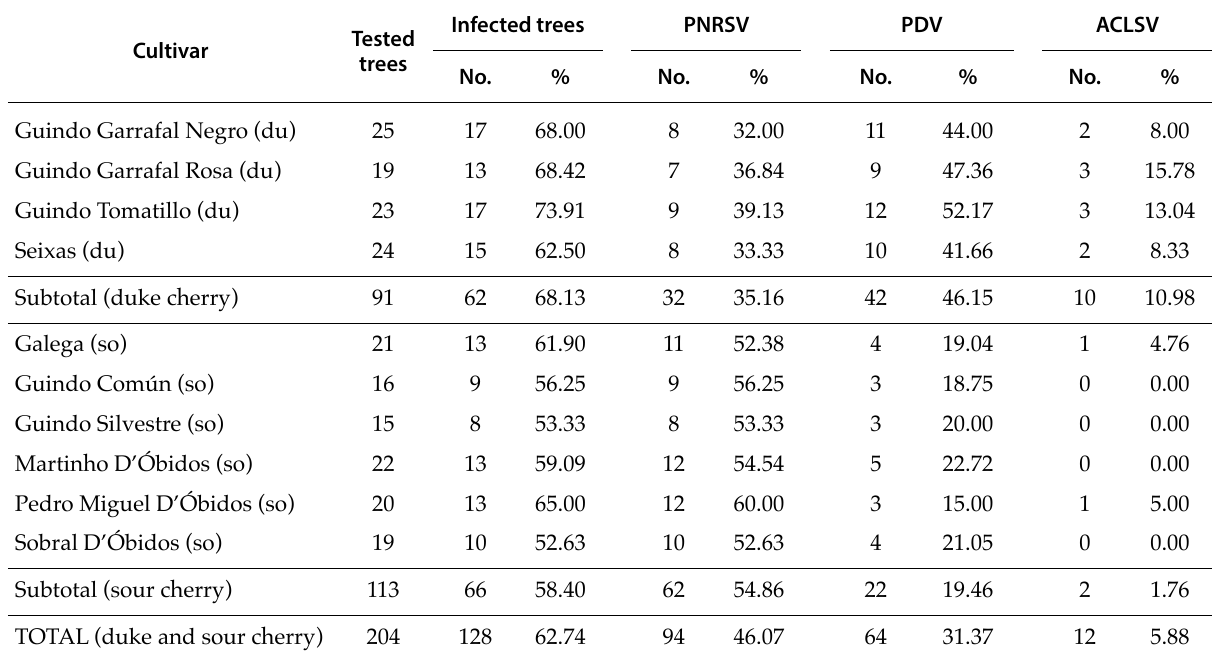
Table 1. Relative incidence of single infections by PDV, PNRSV and ACLSV in sour (so) and duke (du) cherry cultivars from the Iberian Peninsula. ELISA results. Infected Tested Cultivar trees